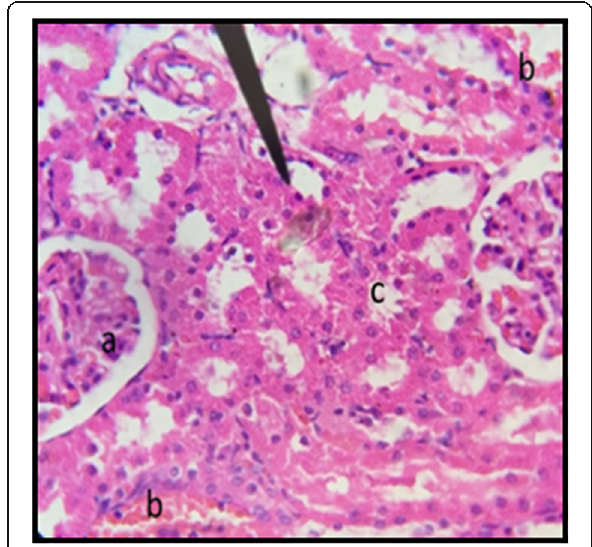
Fig. 7 Kidney Section of Male Rat (100 mg/kg/day) X400. a coalescence of capillaries along with damage to the